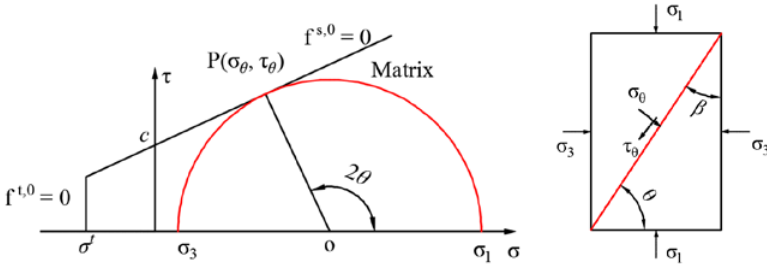
Figure 13. Mohr’s circle and stress state on failure plane.